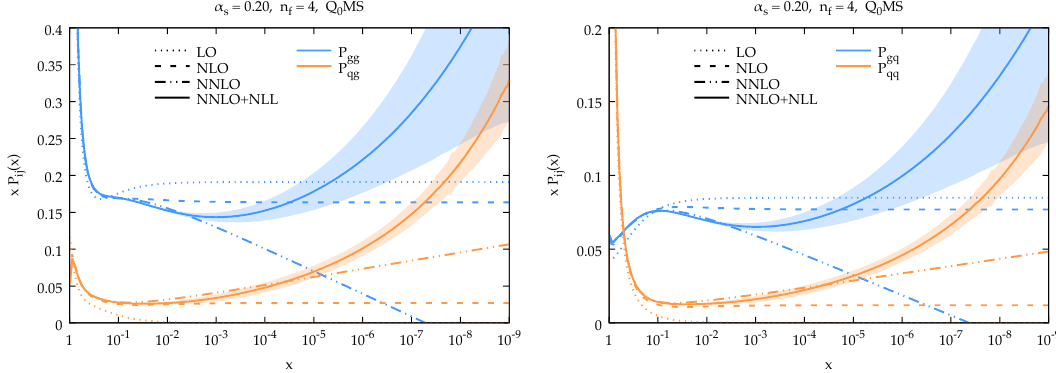
Figure 1 . The resummed and matched splitting functions at NNLO+NLL (solid) accuracy com- pared with the (cid:12)xed-order results at LO (dotted), NLO (dashed) and NNLO (dot-dot-dashed). The left plot shows P gg (blue) and P qg (orange), and the right plot P gq (blue) and P qq (orange). The plots are for (cid:11) s = 0 : 2 and n f = 4 in the Q 0 MS scheme.